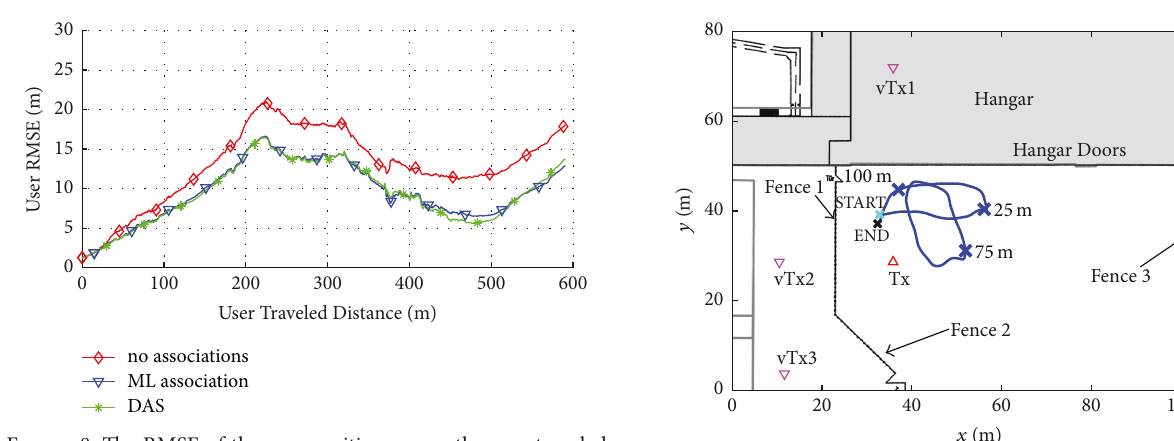
Figure 8: The RMSE of the user position versus the user traveled distance for the simulations. The red curve shows the RMSE if no associations among transmitters are made, the blue curve if the ML method for associations is applied, and the green curve for using DAS.